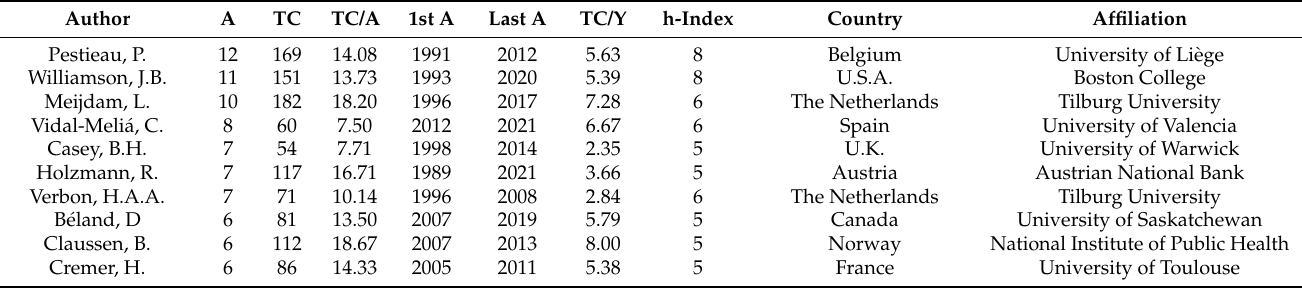
Table 6. The top 10 most productive authors on pension